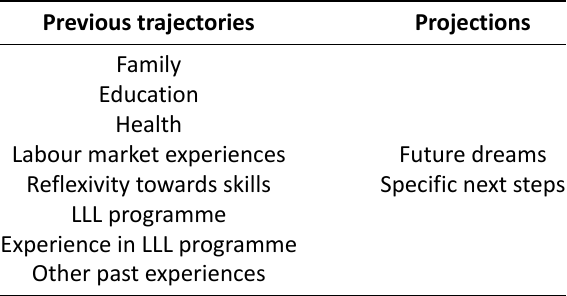
Table 2. Codes for analysing the young adults’